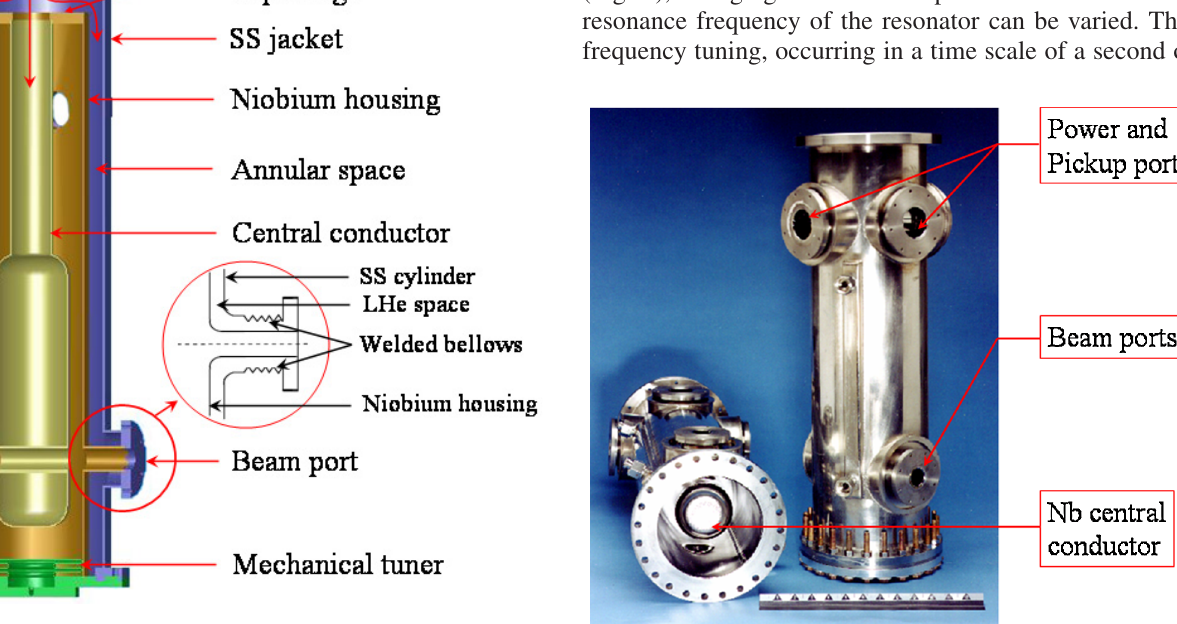
jacket.FIG. 2. (Color) The cross-sectional view of the resonator with the SS jacket, the beam ports, and the dismountable mechanical